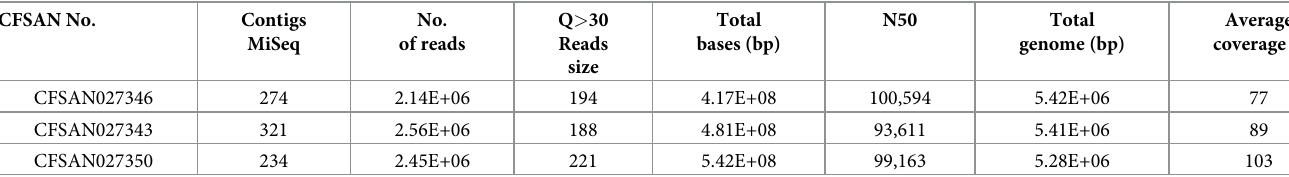
Table 2. MiSeq assembly statistics for the 3 O26:H11 STECs. CFSAN No.